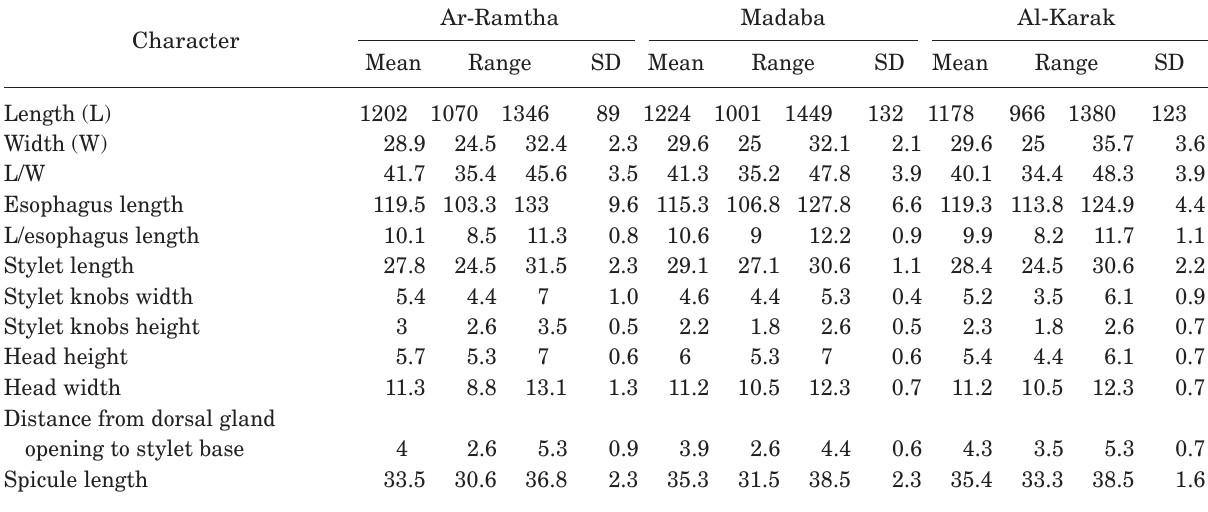
Table 4. Morphometric data (µm or ratio) of males (n=10) of three Heterodera latipons